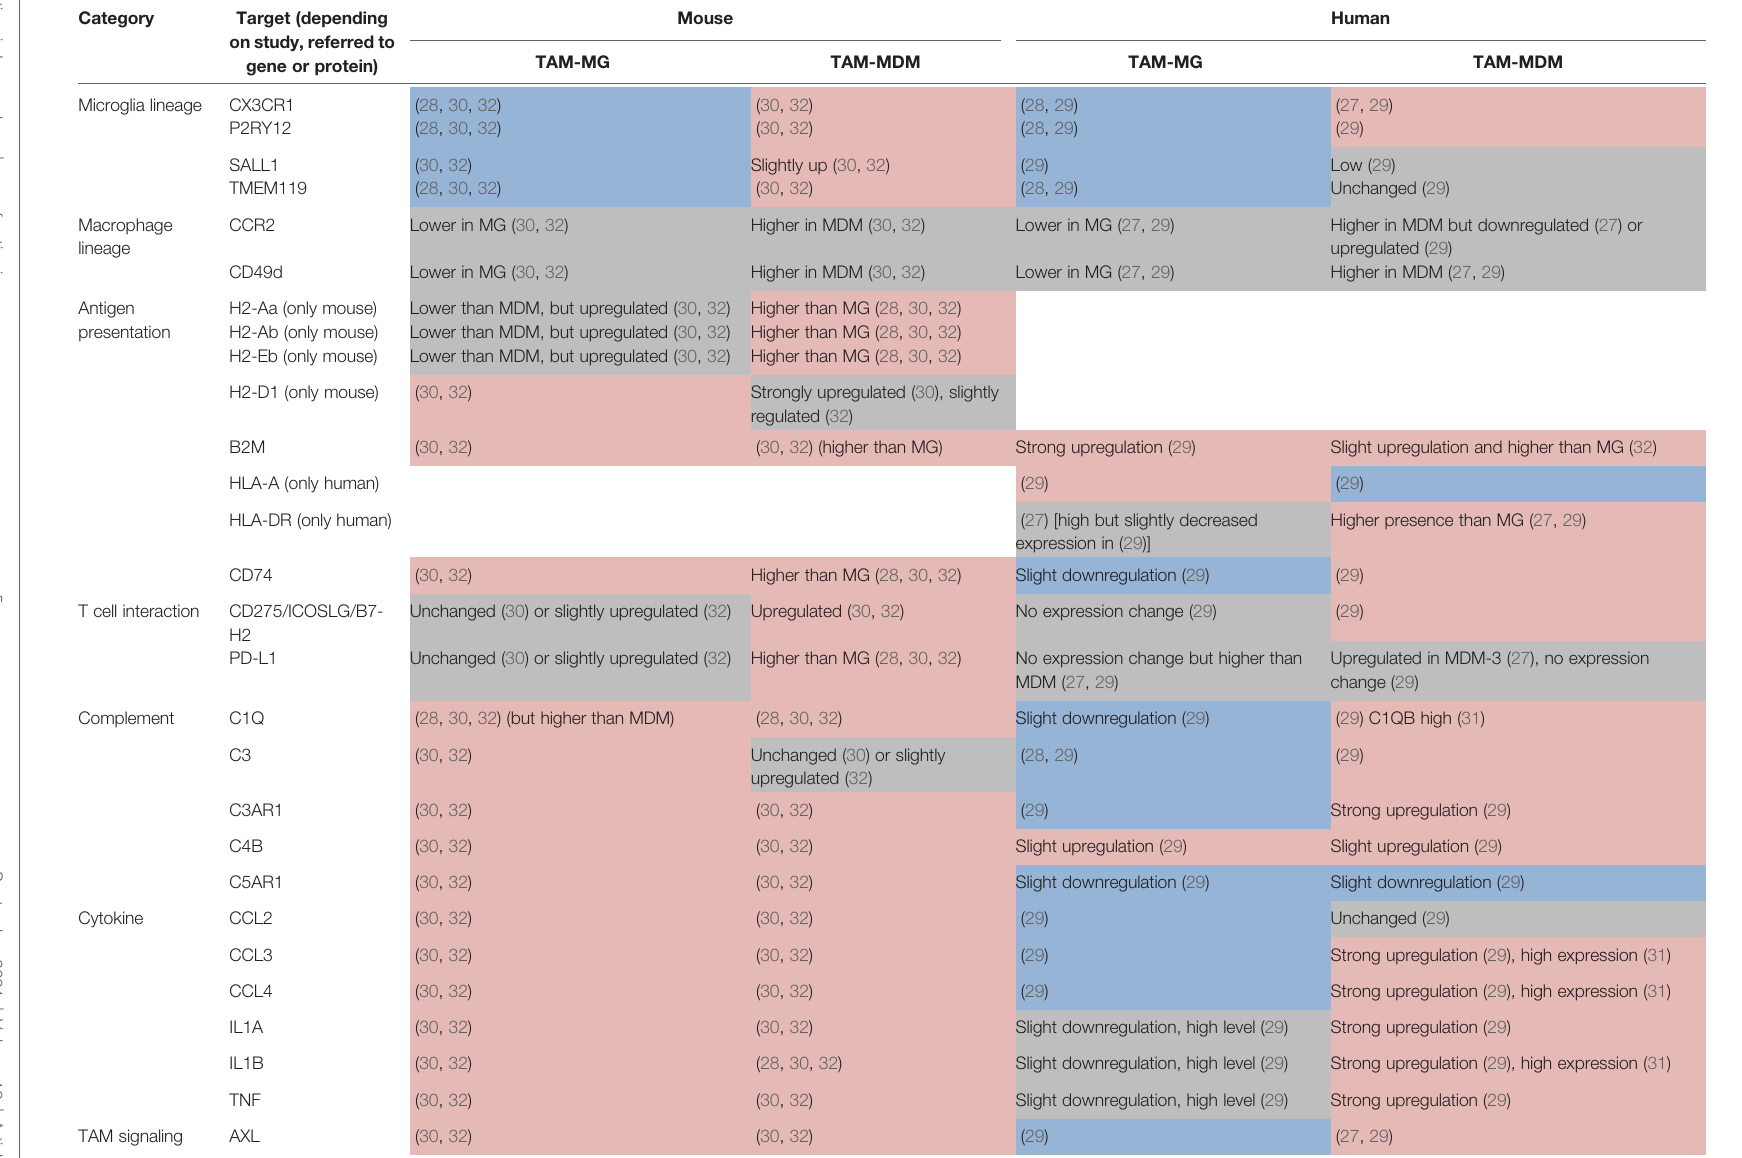
TABLE 2 | Selected markers and their regulation within murine (left) and human (right) TAM-MG and TAM-MDMs.